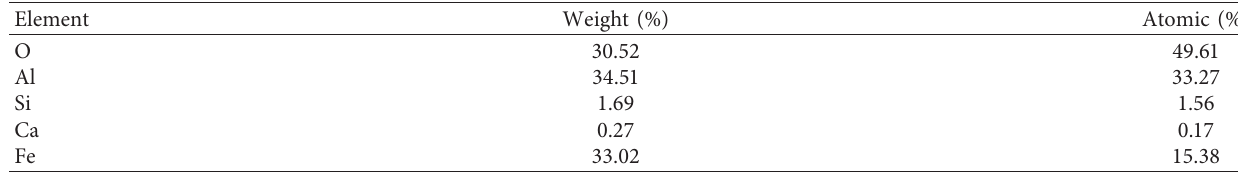
Table 1: The bauxite rock’s main chemical composition.